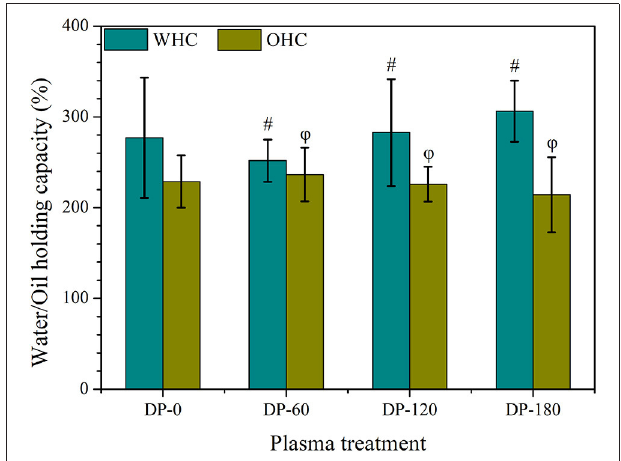
FIGURE 2 | The water and oil holding capacity of RPA in DP-0, DP-60, DP-120, and DP-180 groups. # and φ represents p > 0.05 vs. the DP-0 group.